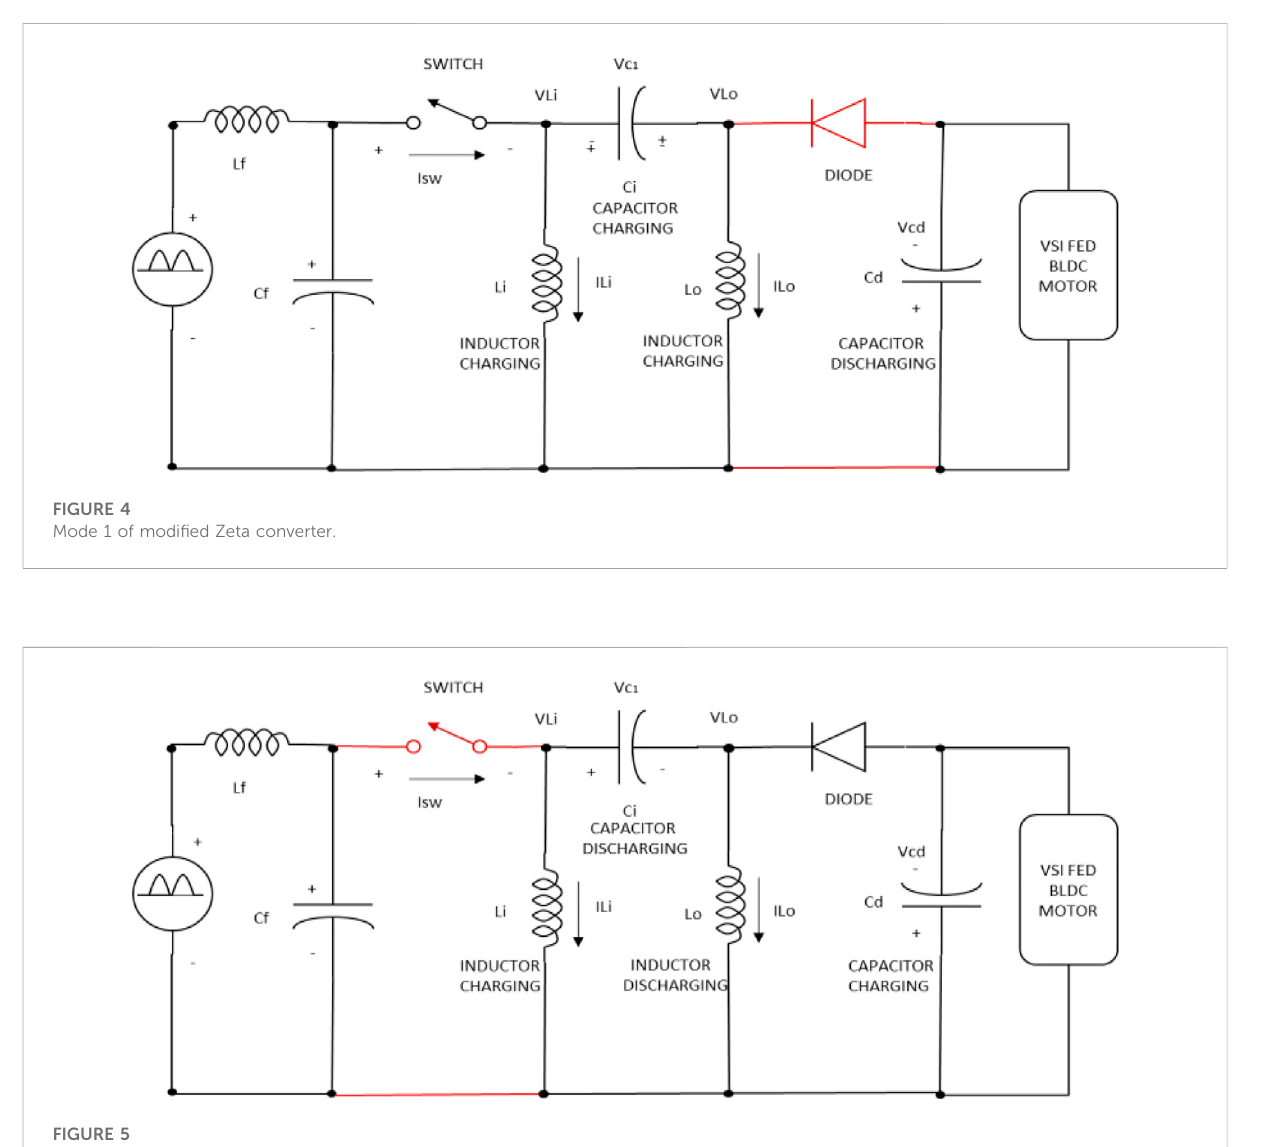
FIGURE 5 Mode 2 of modi fi ed Zeta